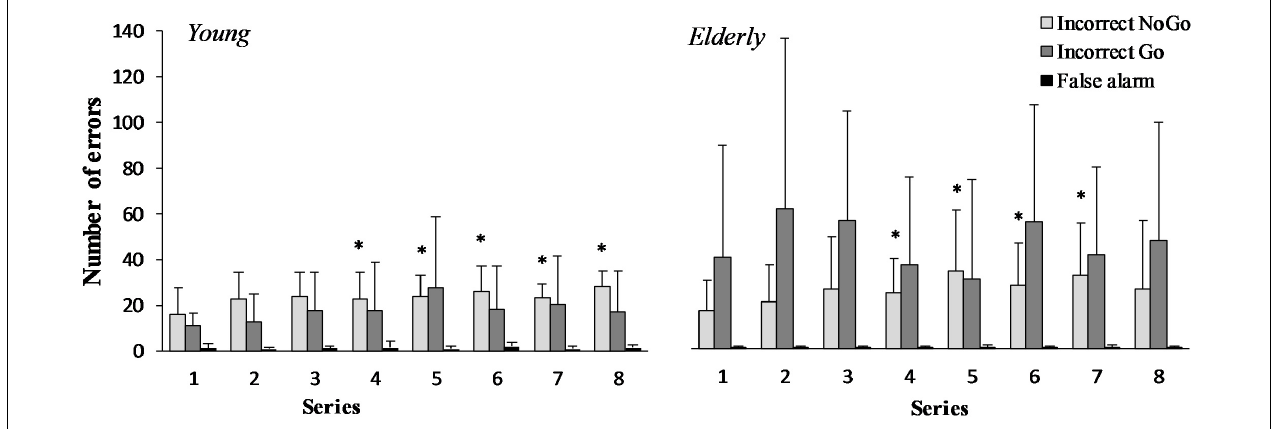
FIGURE 2 | “Incorrect NoGo,” “Incorrect Go,” “False alarm” errors during 2 h “Go/NoGo” task in young and elderly men. ∗ p < 0.05 compared with the first series.